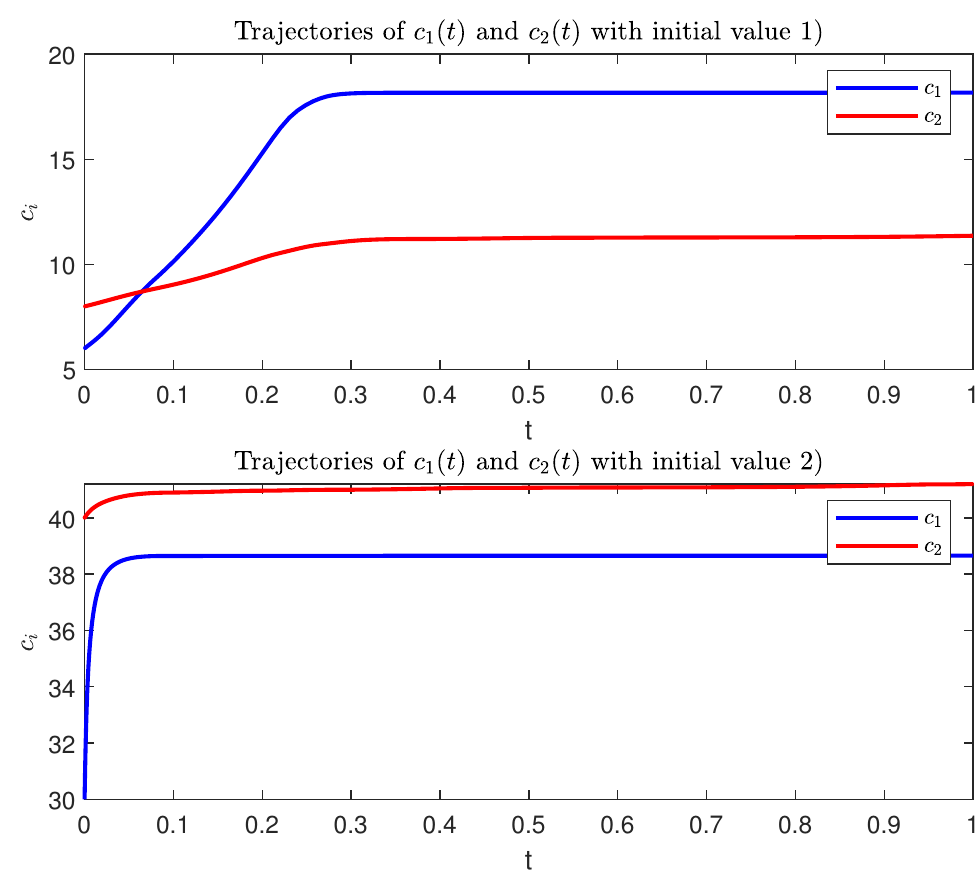
Figure 11. The curves of c 1 ( t ) and c 2 ( t ) with different initial values (1) and